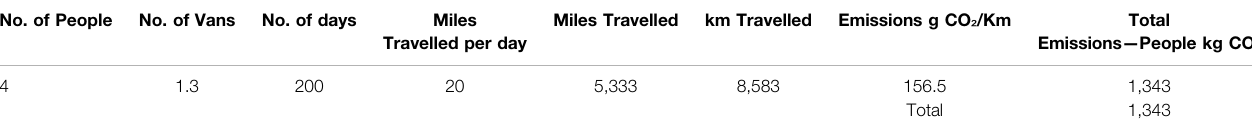
TABLE 4 | Emissions from people travel.